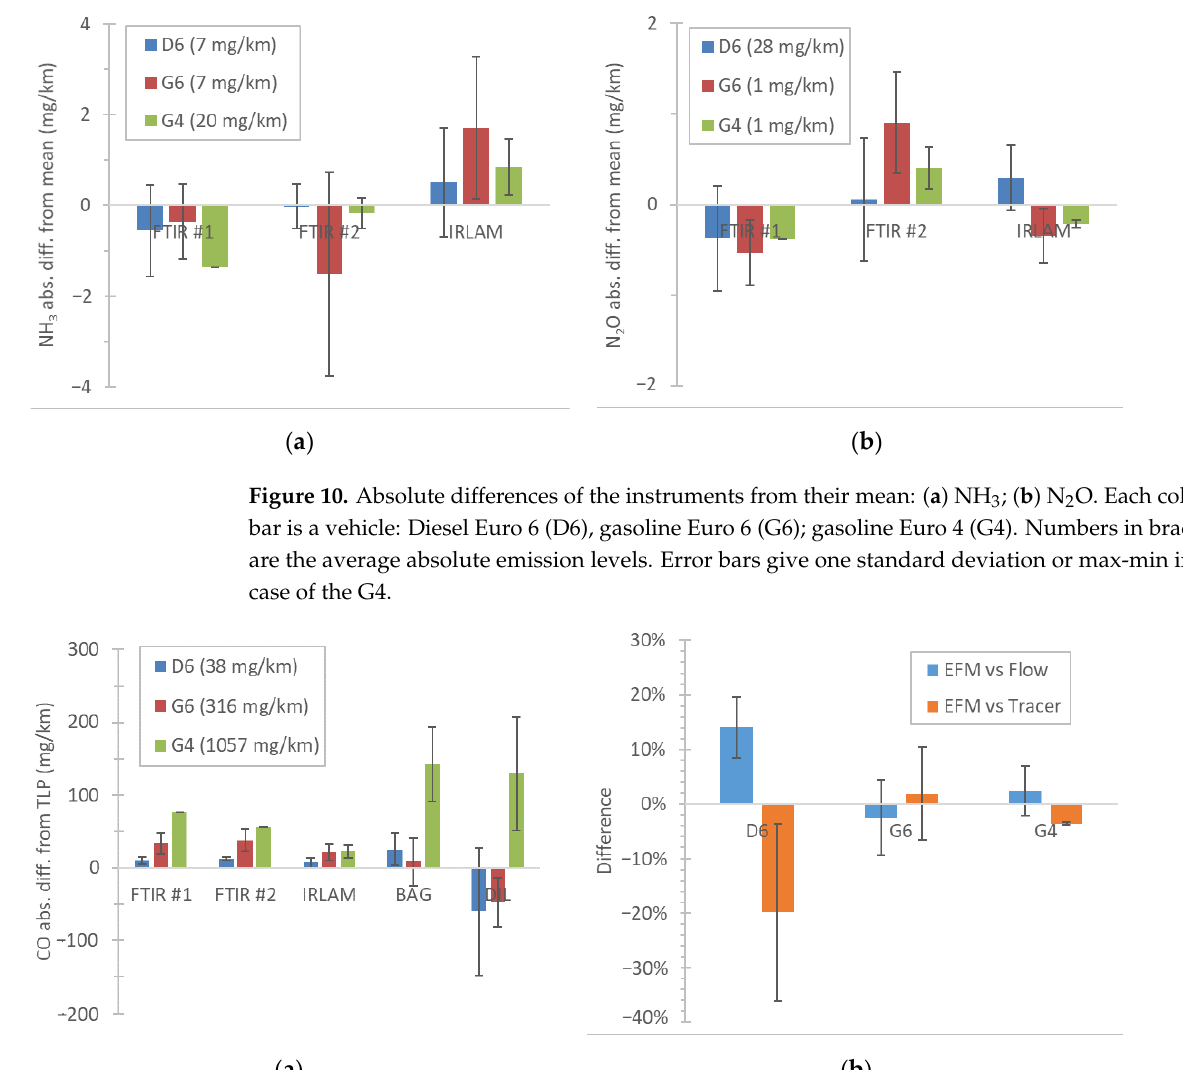
( b ) Figure 9. Absolute differences of the instruments from tailpipe analyzers (TLP): ( a ) CO 2 ; ( b ) NO x . Each colored bar is a vehicle: Diesel Euro 6 (D6), gasoline Euro 6 (G6); gasoline Euro 4 (G4). Numbers in brackets are the average absolute emission levels over the driven cycles for each vehicle. Error bars give one standard deviation or max-min the G4. Figure 10a summarizes the NH 3 results. The differences including one standard de- viation were within ±3.5 mg/km, with typical mean differences within ±1.5 mg/km. Figure 10b summarizes the N 2 O results. The differences were in most cases within ±1 mg/km.